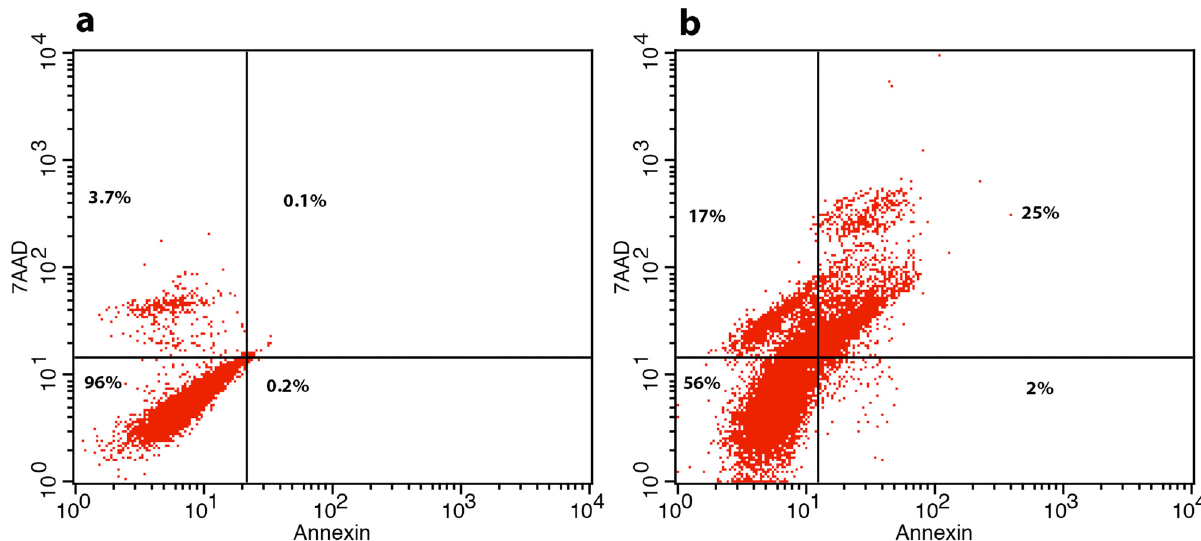
Figure 4: Flow cytometric analysis of ZnO - NPs - induced HEK - 293 cells apoptosis. Flow cytometry dot plots of Annexin V - FITC/7 - AAD double staining of control HEK - 293 cells without treatment ( a ) and after treatment with ZnO - NPs ( b ) .